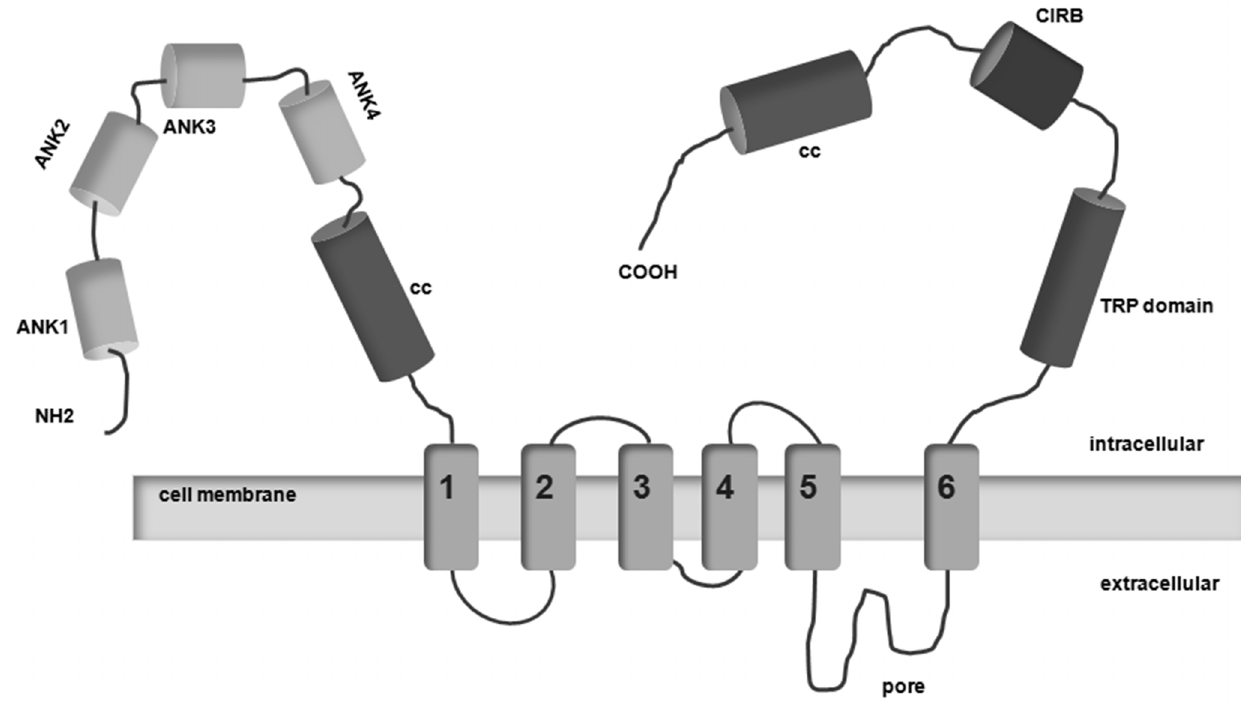
Figure 1. TRPC6 topology. Structure of the TRPC6 monomer. TRPC6 belongs to the large family of TRP channels, which contain six transmembrane domains, one pore-forming region and large intracellular N- and C-tails. Four subunits are required to assemble a functional channel. In the pococyte, TRPC6 is part of the slit diaphragm multiprotein complex. TRP: transient receptor potential, ANK: Ankyrin repeat, cc: coiled–coiled domain, CIRB: CaM/IP3R-binding domain.